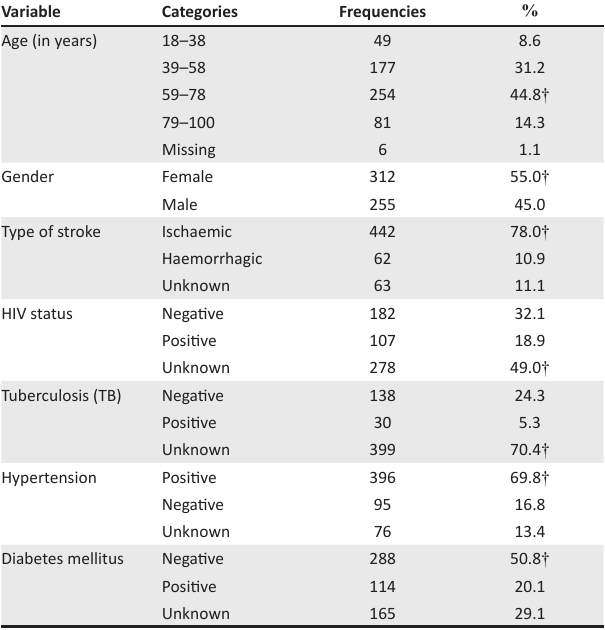
TABLE 1: Demographic profile of stroke survivors admitted to Chris Hani Baragwanath Academic Hospital between September 2018 and May 2019 ( n = 567).